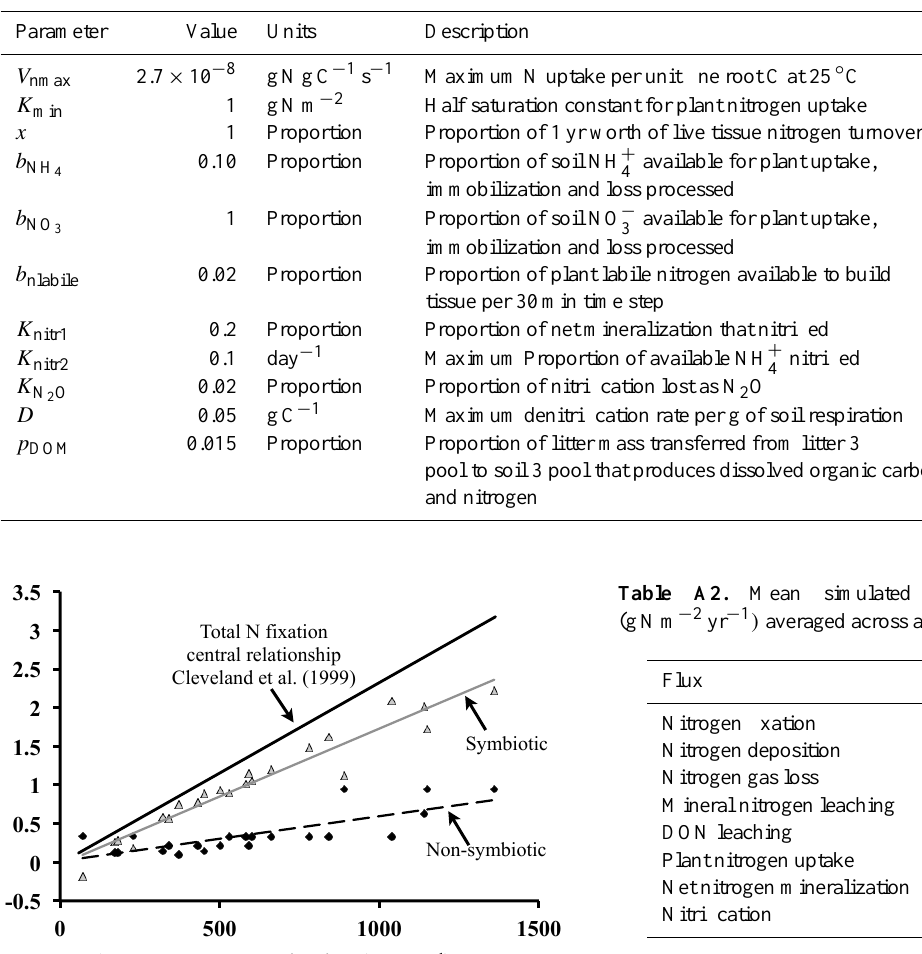
Table A1. New parameters introduced to the CLM-CN 4.0.